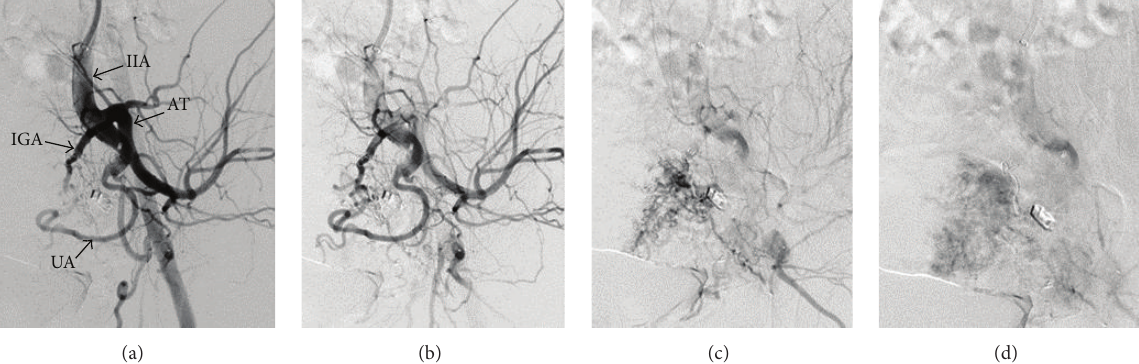
Figure 3: DSA after embolization. (a) Arterial phase: “IIA: internal iliac artery; IGA: inferior gluteal artery; UA: uterine artery; AT: anterior trunk of internal iliac artery.” (b) Delayed arterial phase without venous opacification. (c) Early venous phase with minimal venous pouch opacification. (d) Late venous phase with no direct opacification of the venous pouch from the